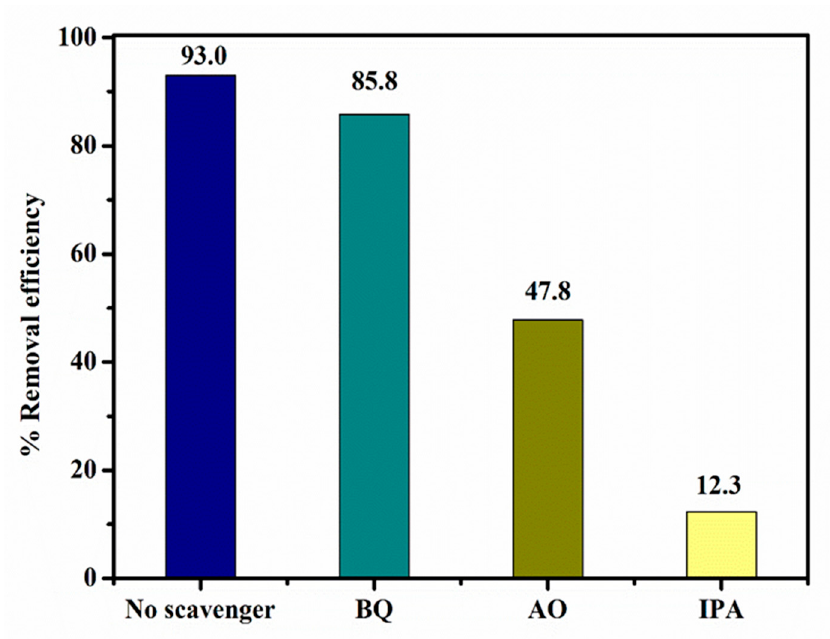
Figure 7. Effects of different scavengers on the photocatalytic degradation of IMI.